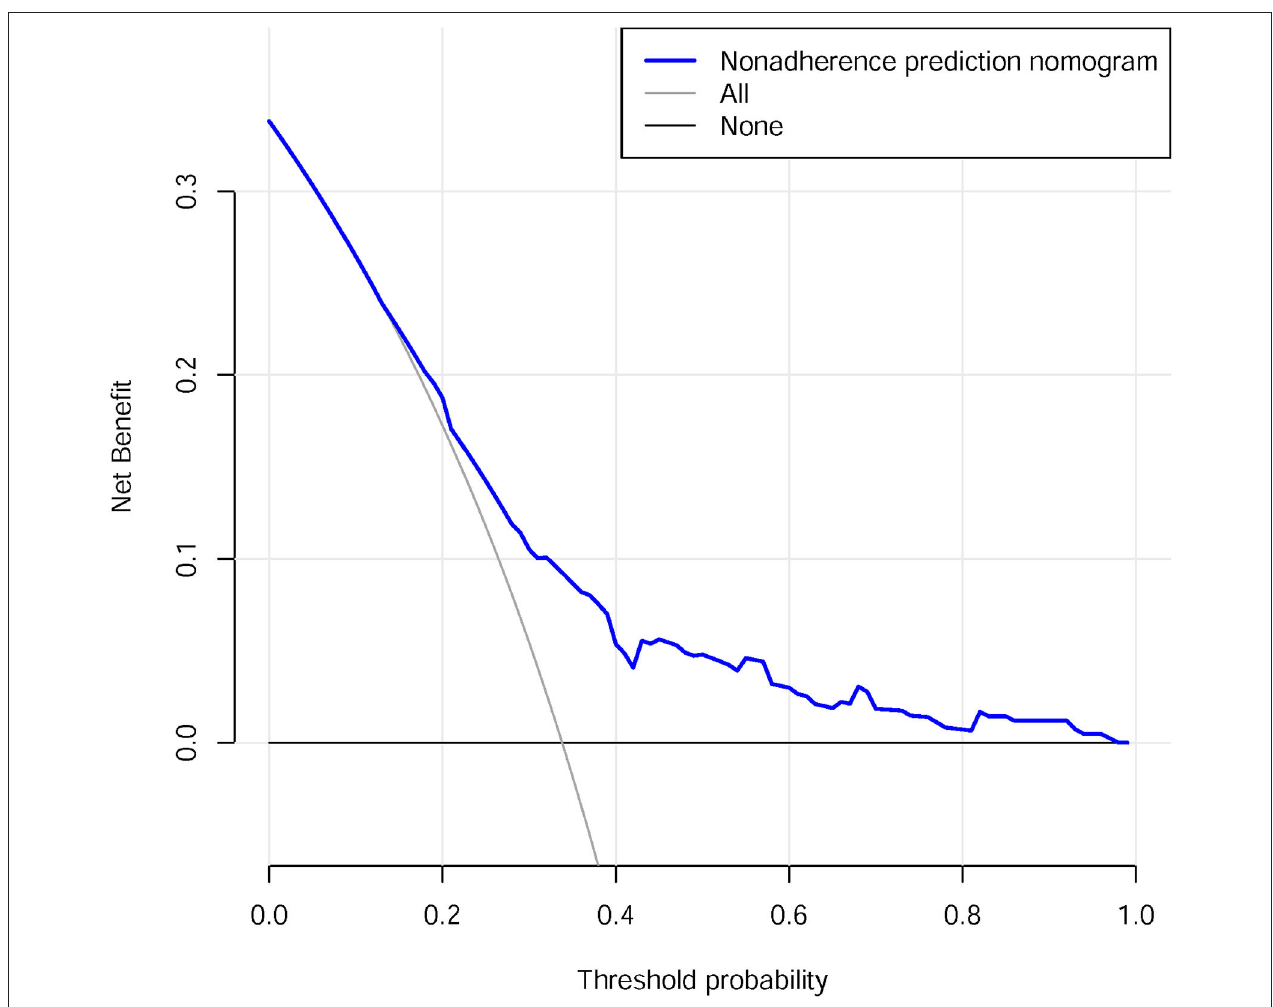
FIGURE 4 | Decision curve analysis for the PROM